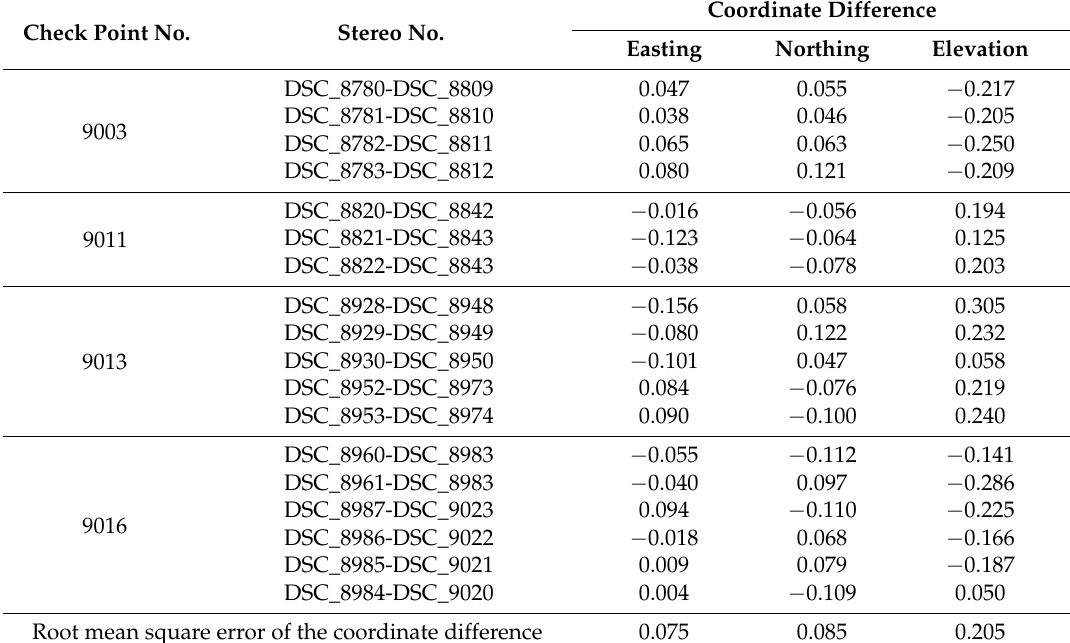
Table 2. The coordinate differences of check points from inter-strip stereo image pair (unit: m).